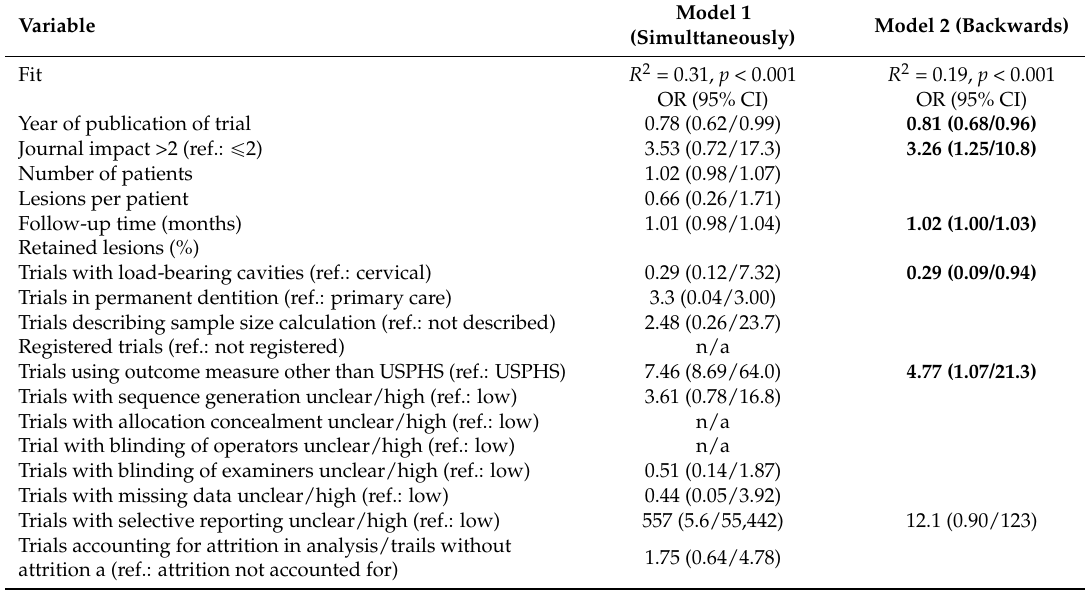
Table 3. Factors associated with studies yielding significantly different failure rates between